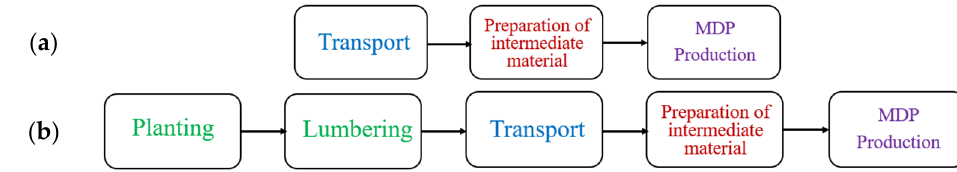
Figure 8. System boundaries: ( a ) Scenario I and ( b ) Scenario II.